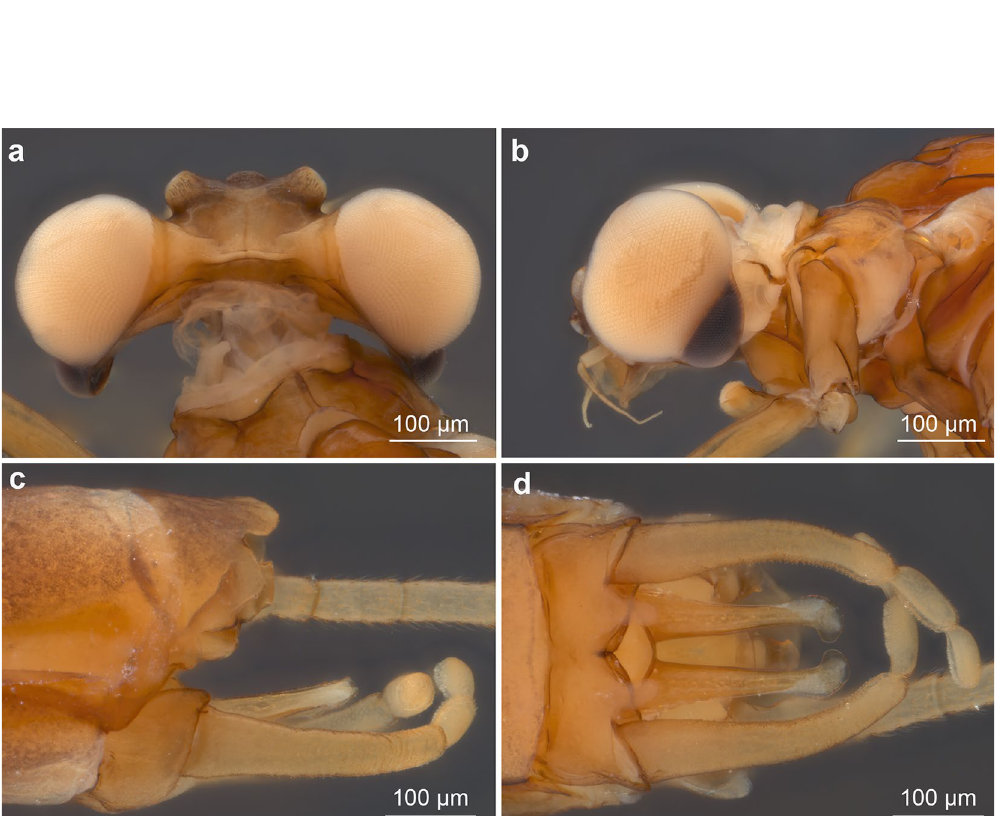
Figure 10. Calliarcys humilis Eaton, 1881, male imago [Spain; Sartori M. coll.]: ( a ) head and anterior part of thorax in dorsal view; ( b ) head and anterior part of thorax in left lateral view; ( c ) tip of abdomen with genitalia in left lateral view; ( d ) genitalia in ventral